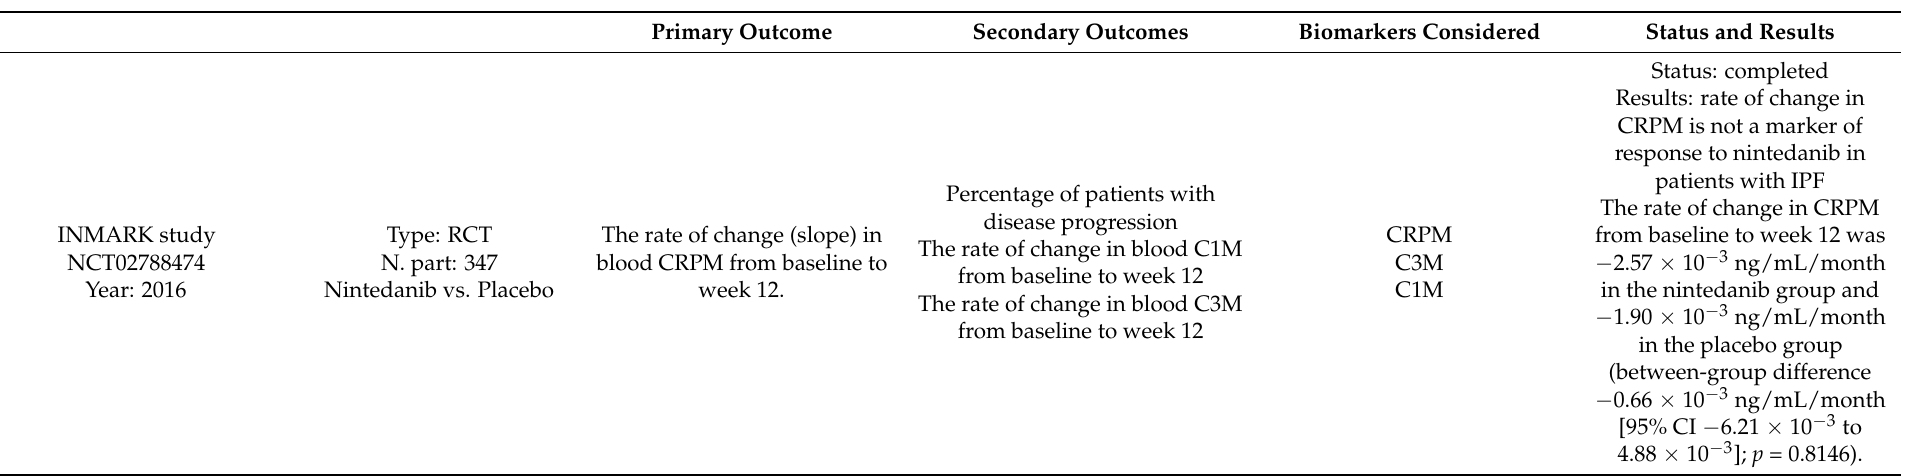
Table 3. Therapeutic biomarkers in